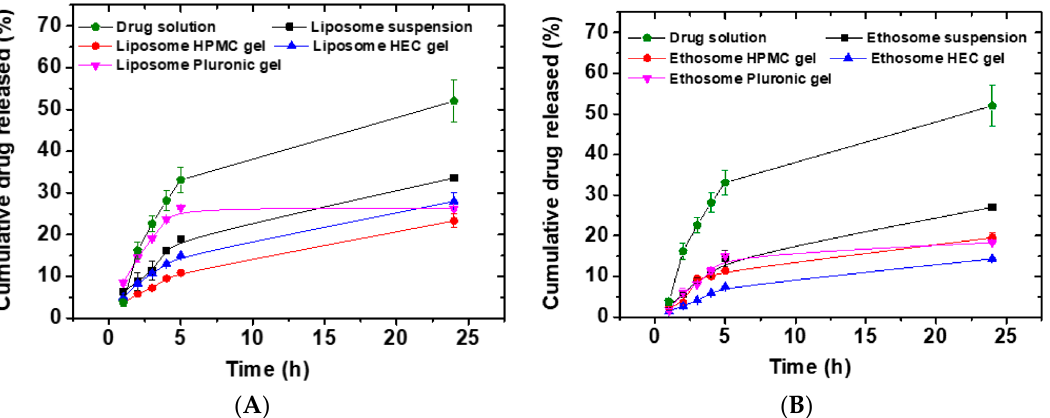
Figure 4. In vitro cumulative percent anthralin released as a function of time from anthralin-loaded liposomes (L5) and anthralin-loaded liposomes suspended into various gel bases ( A ) and from anthralin-loaded ethosomes (E4) and anthralin-loaded ethosomes suspended into various gel bases ( B ).